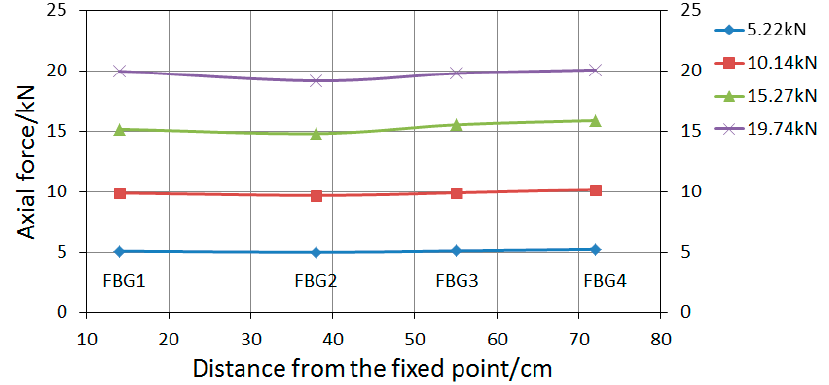
Figure 18. The variation curve of the axial force of the bolt-shaft in “Active”